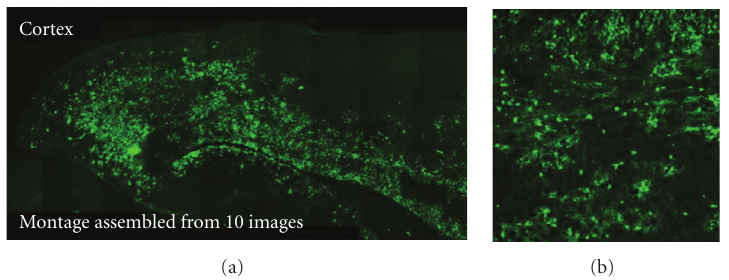
Figure 11: Detection of viral antigen spread by EGFP fluorescence. Mice ware sacrificed at day 5 p.i. Brain was removed and processed for frozen sections. A portion of sagittal brain sections was cut from the middle of the brain of infected mice. Frozen sections were processed for detection of viral antigen distribution by EGFP fluorescence. Bright EGFP fluorescence was spread throughout the brain section as showed by montage assembled from 10 serial images (a). Higher magnification image (b) from the same brain section shows the cellular distribution of EGFP fluorescence. (adapted from the wprk of